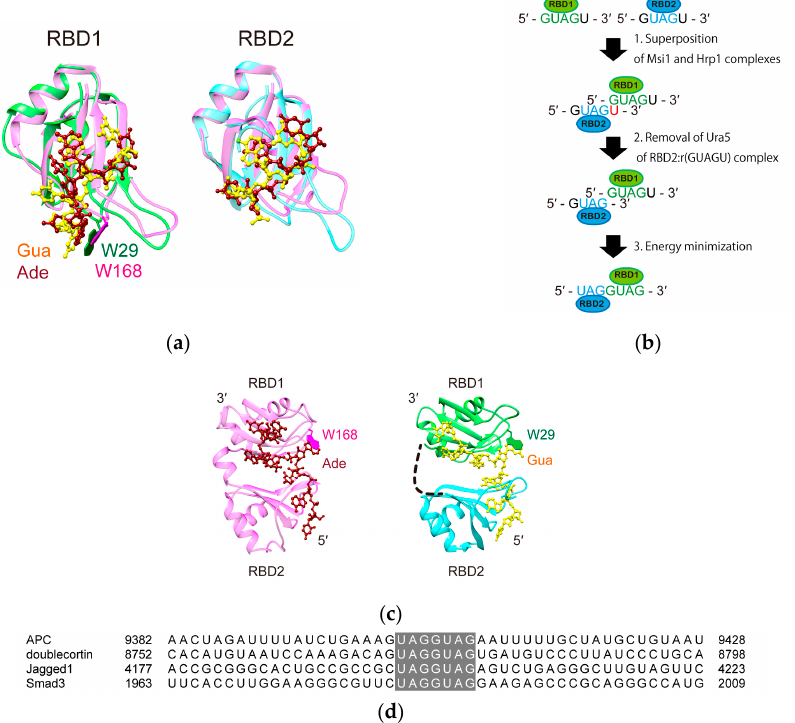
Figure 5. A model structure of Msi1 RBD1-2 bound to the minimal target sequence, r(UAGGUAG). ( a ) Consecutive RBDs, RBD1-2, of Hrp1 (Lys156-His322), which are connected by a short linker (Ile234–Gly243), reportedly binds to r(UAUAUAUA). The structures of the Msi1 RBD1:r(GUAG) complex (green and yellow) and Hrp1 RBD1:r(AUAU) complex (pink and red) (left), and those of the Msi1 RBD2:r(UAG) complex (cyan and yellow) and Hrp1 RBD2:r(UAU) complex (pink and red) (right) are superimposed. Note that in both pairs, the binding regions are superimposed very well. One of the characteristic interactions between Msi1 RBD1 and r(GUAG), stacking of the aromatic rings of W29 and Gua1, was similarly found in the Hrp1 RBD1:RNA complex (W168 and Ade4) (labeled in the Figure); ( b ) A schematic illustration of the model building steps; ( c ) On the basis of the similarities found in ( a ), we used the solution structure of the Hrp1:r(UAUAUAUA) complex (PDB ID: 2CJK) (left) as a template and built a model structure containing the both RBDs of both Msi1 and r(UAGGUAG) (right). The W29 in Msi1 and W168 in Hrp1 are shown as green and magenta sticks, and labelled, respectively; ( d ) Alignment of the 3 ′ -UTR regions of the Msi family target mRNAs, containing the r(UAGGUAG) sequence (highlighted in grey): H. sapiens APC (accession code NM_001127511.2), H. sapiens doublecortin (NM_000555.3), H. sapiens Jagged 1 (NM_000214.2), and H. sapiens Smad3 (NM_005902.3).